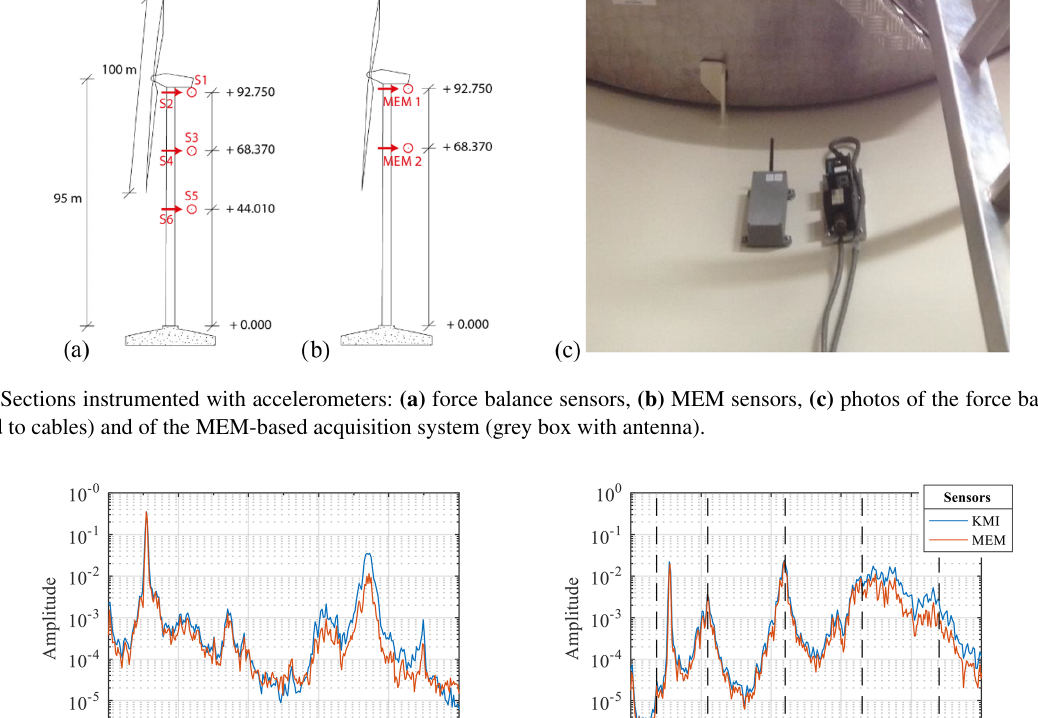
close to the foundation (near the base flange), while the other two are positioned according to Fig.